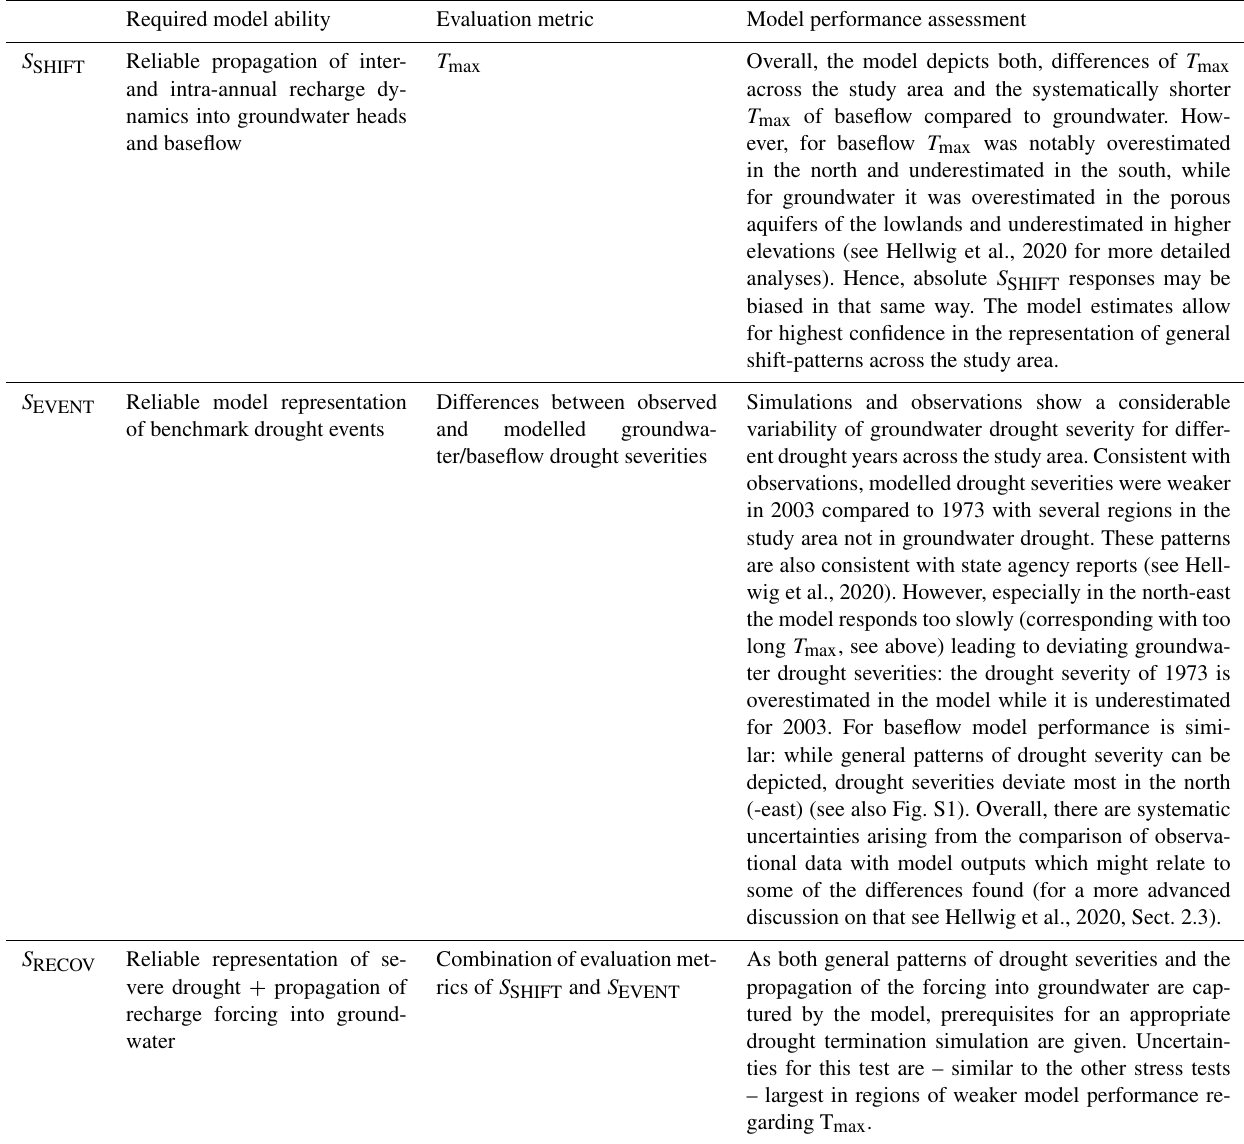
Table 2. Required model ability and discussion of model performance for the different stress